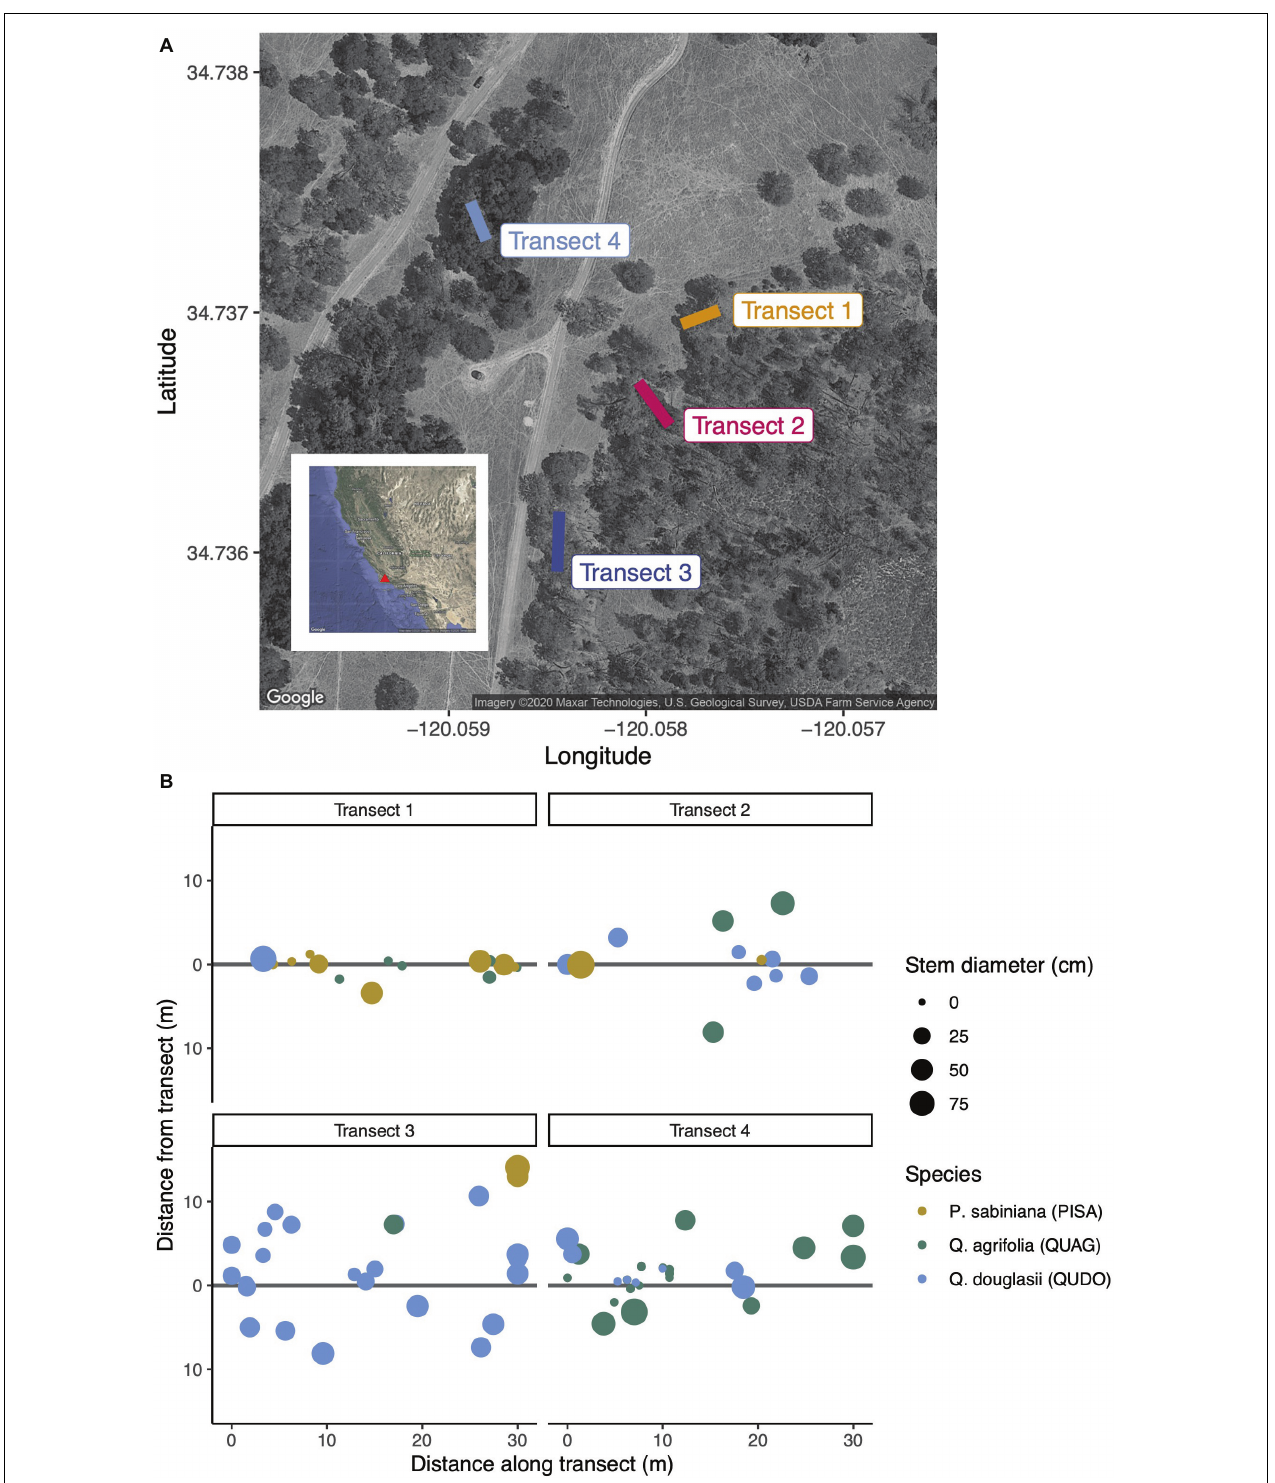
FIGURE 1 | (A) Four 30 m transects were selected to capture different canopy communities across the mixed conifer-hardwood forest at Sedgwick Reserve in Santa Barbara County, CA, United States. The maximum distance between two transect endpoints (Transect 3 and Transect 4) is approximately 175 m. (B) Canopy communities were inventoried based on their minimum distance to the transect. The species surveyed were Pinus sabiniana (PISA, brown circles), Quercus agrifolia (QUAG, green circles), and Q. douglasii (QUDO, blue circles). Circle size is proportionate to stem diameter (DBH), and distance from the transect represents physical location of each